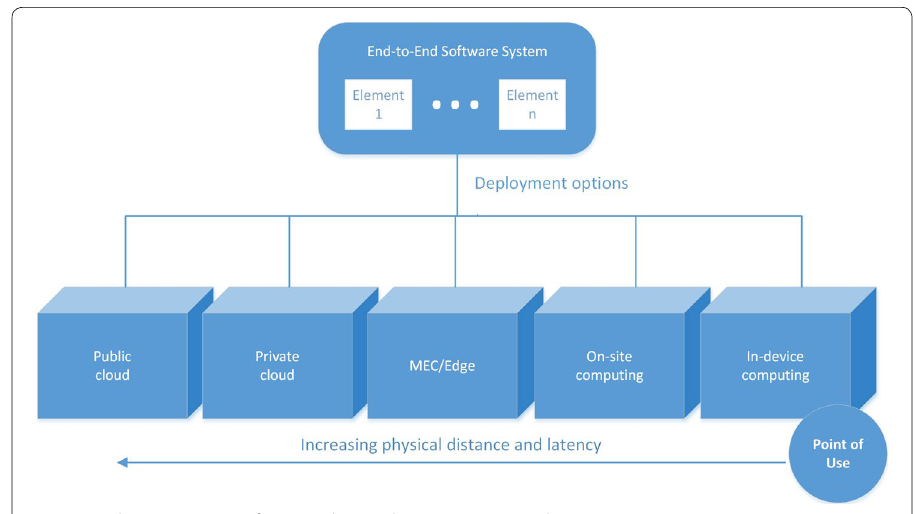
Fig. 1 Deployment options for an end-to-end SWsystem in an edge computing